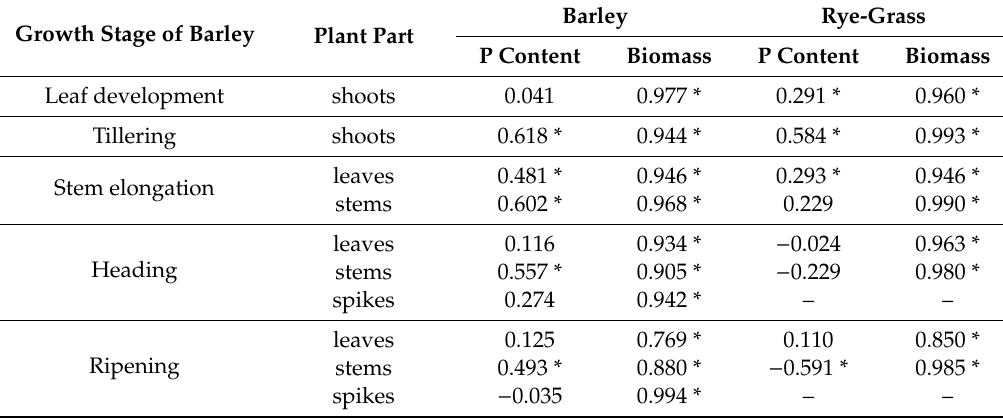
Table 2. Coe ffi cients of correlation (r) between phosphorus accumulation and phosphorus (P) content and the above-ground biomass of